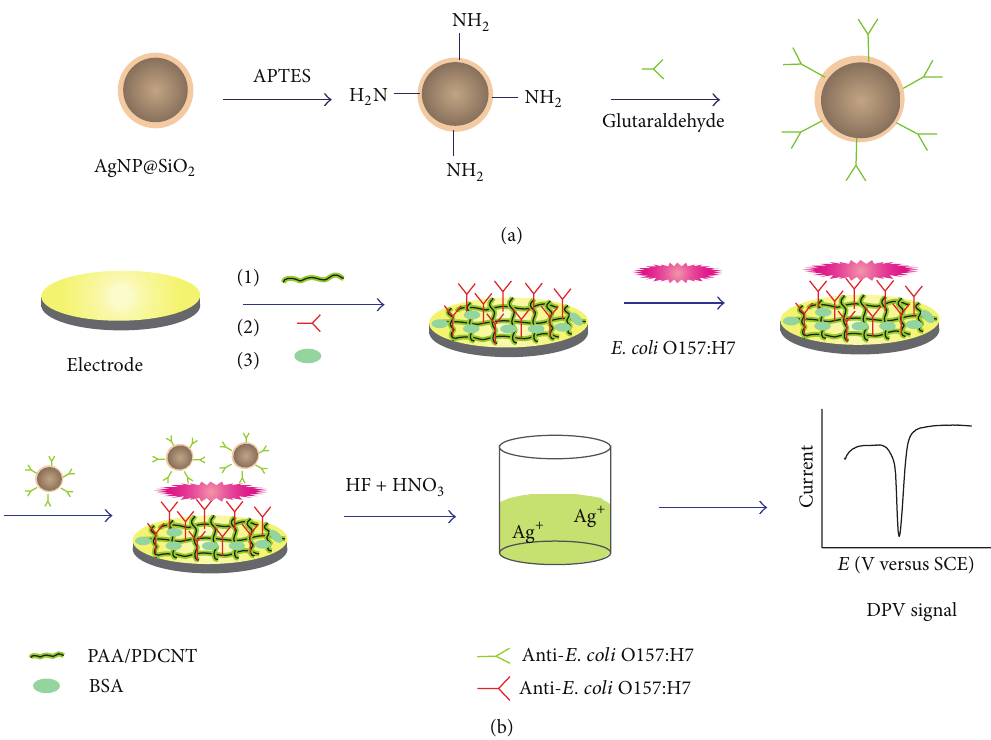
Scheme 1: Schematic illustration of the stepwise fabrication process of (a) Ag@SiO 2 -conjugated anti- E. coli O157:H7, and (b) the